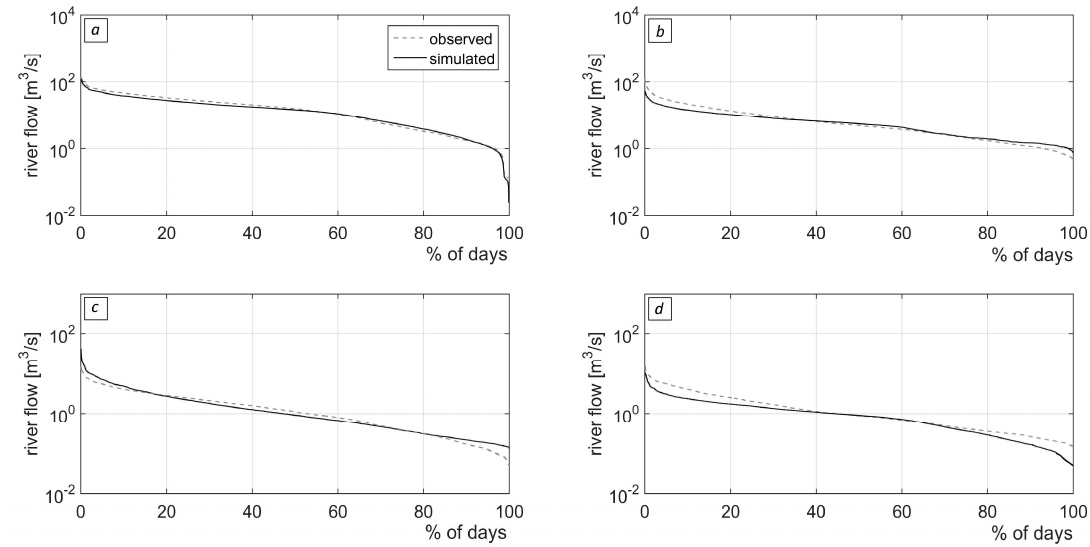
Figure 9. Comparison between flow duration curves from observed and simulated daily river flow: ( a )